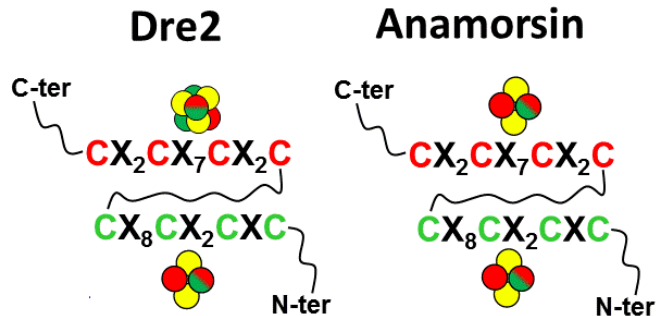
Figure 4. Fe/S cluster binding nature and coordination at the two highly conserved cysteine-rich motifs of Dre2 and anamorsin (CX 8 CX 2 CXC, motif I, and CX 2 CX 7 CX 2 C, motif II, where X indicates any amino acid) obtained by EPR and Mössbauer spectroscopies. Red/green sphere is Fe(III) ion (for Mössbauer spectra) or Fe(II) ion (for EPR spectra), green sphere is Fe(II) ion, red sphere is Fe(III) ion and yellow sphere is sulfide